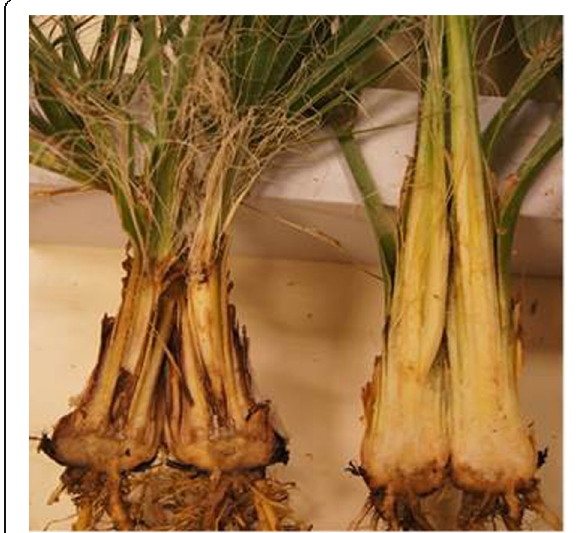
Fig. 5 Splitting of a diseased plant (left) showing internal symptoms of terminal bud rot on 1-year-old Washingtonia robusta trees artificially inoculated with Phytophthora nicotianae and maintained in a greenhouse for 5 weeks. A non-inoculated tree